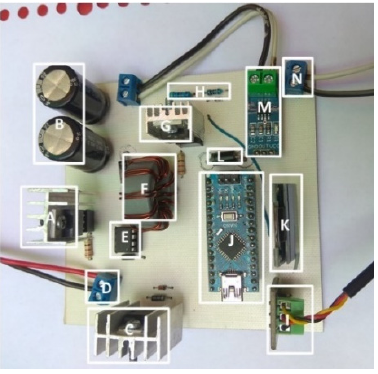
Figure 7. System hardware.